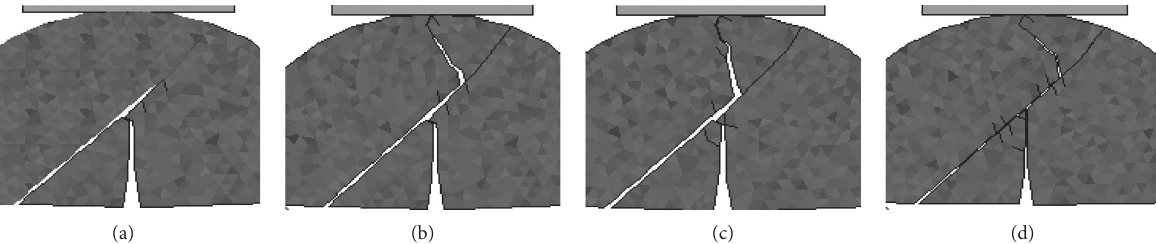
Figure 2: Specimen failure patterns under different loading rates obtained by the improved DDA simulation: (a) 0.02 m/s; (b) 0.03m/s; (c) 0.04m/s; (d) 0.05 m/s.